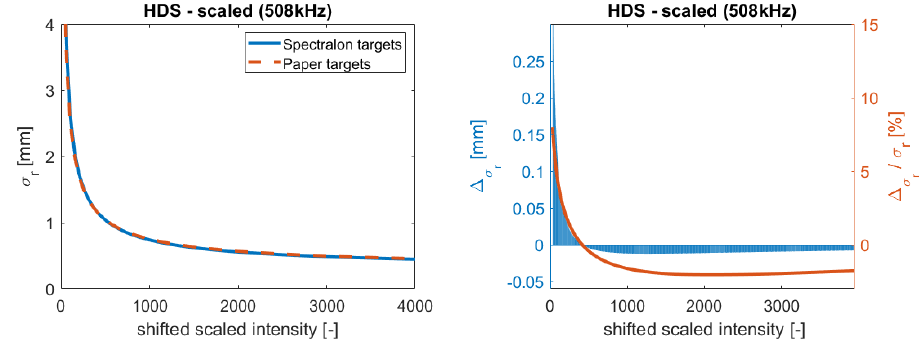
Figure 13. Comparison of functions estimated with Spectralon targets and with the paperboard setup using scaled intensity